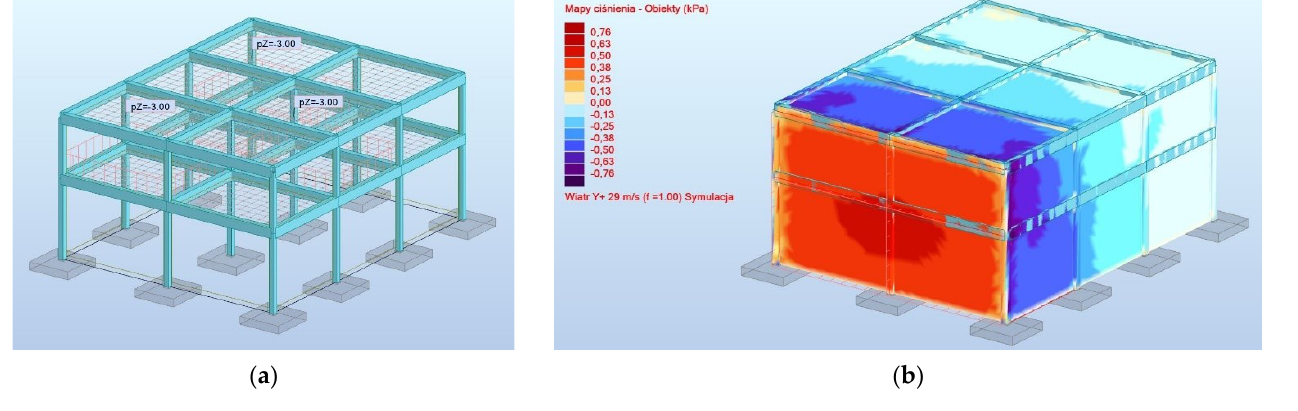
Figure 5. An exemplary load acting on the analyzed reinforced concrete structure: ( a ) example service load; ( b ) example wind load (push on gable wall).